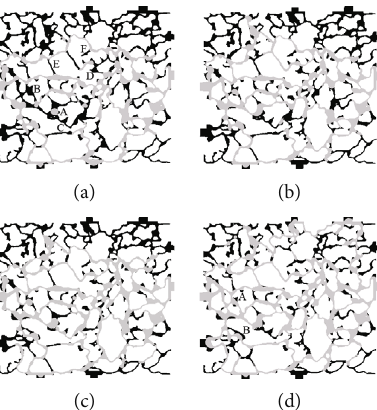
Figure 6: Final oil-water distribution at di ff erent water injection rates under oil-wet conditions: (a) 0.10m · s -1 ; (b) 0.15m · s -1 ; (c) 0.20m · s -1 ; (d) 0.25m · s -1